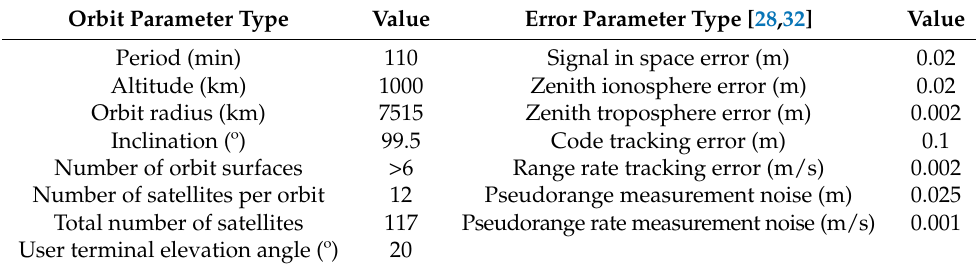
Table 1. The main parameters of the Telesat